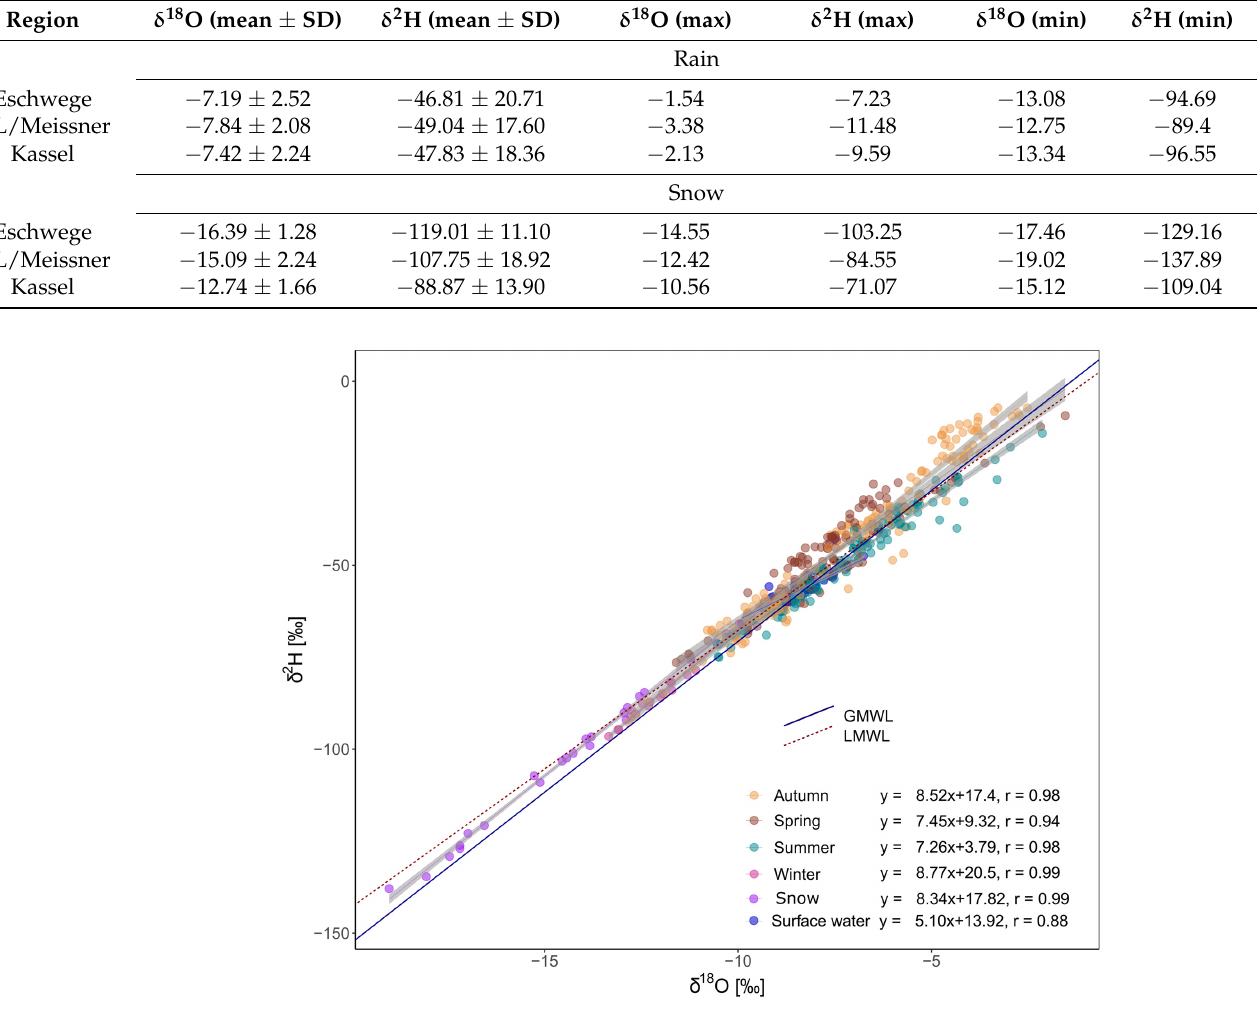
Figure 3. Dual ( δ 18 O and δ 2 H) isotope plots of rainwater, snow, and surface water samples of different elevations separated into four seasons in comparison to the local meteoric water line (LMWL) and the global meteoric water line (GMWL). The grey shadings represent the 95% confidence interval of the linear regression